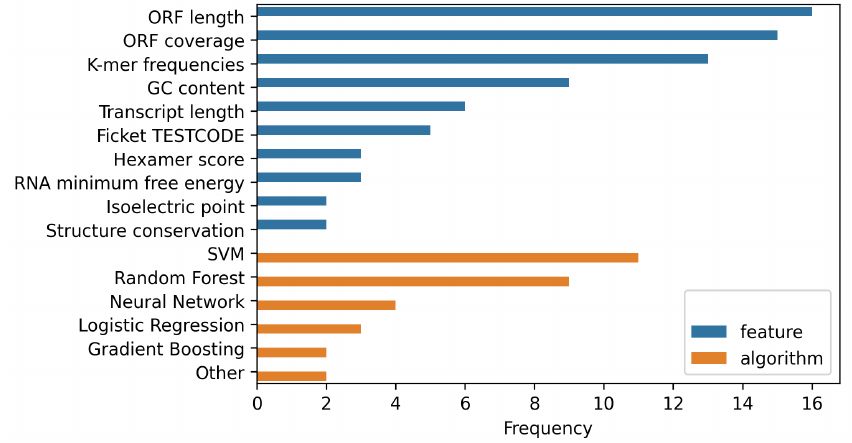
Figure 1. A comparison of the frequencies of commonly used features (blue) and algorithms (orange) applied by different contemporary tools. A majority of the latter rely on open reading frame (ORF) information to make predictions. Other often utilized features include subsequence ( k -mer) frequencies and GC content. SVMs and Random Forests dominate the field as the most commonly implemented algorithms. This is not surprising, as they are two of the by far most flexible approaches for nonlinear